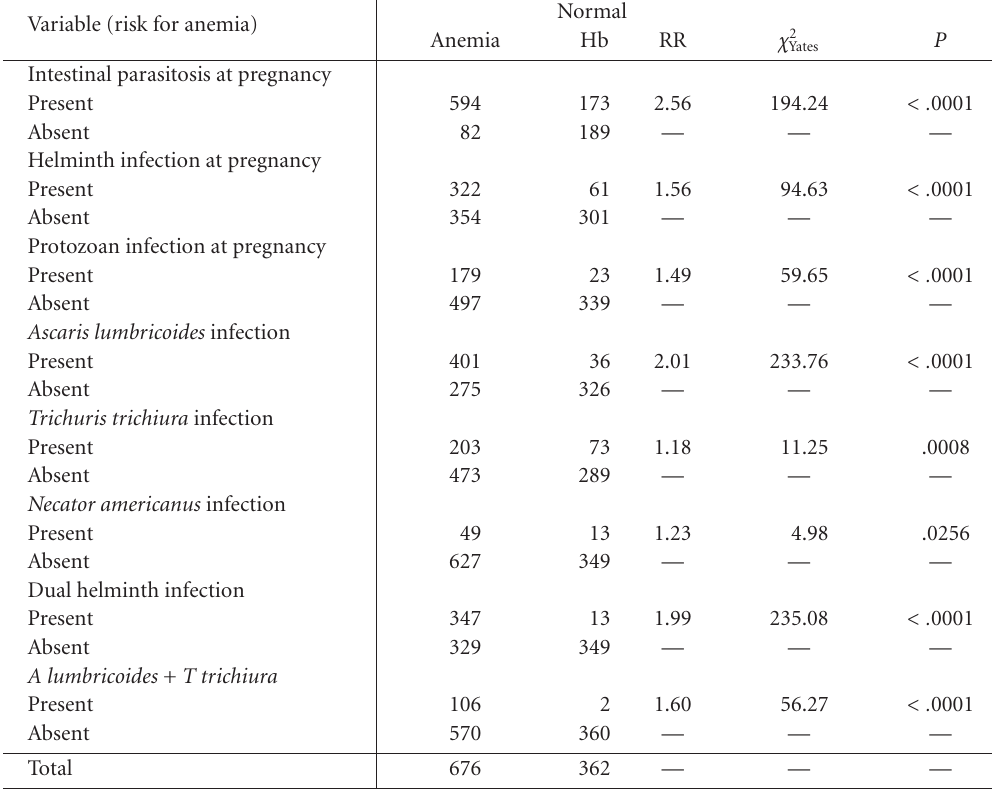
Table 2: Relative risk for anemia at pregnancy according to the presence of intestinal parasitosis.